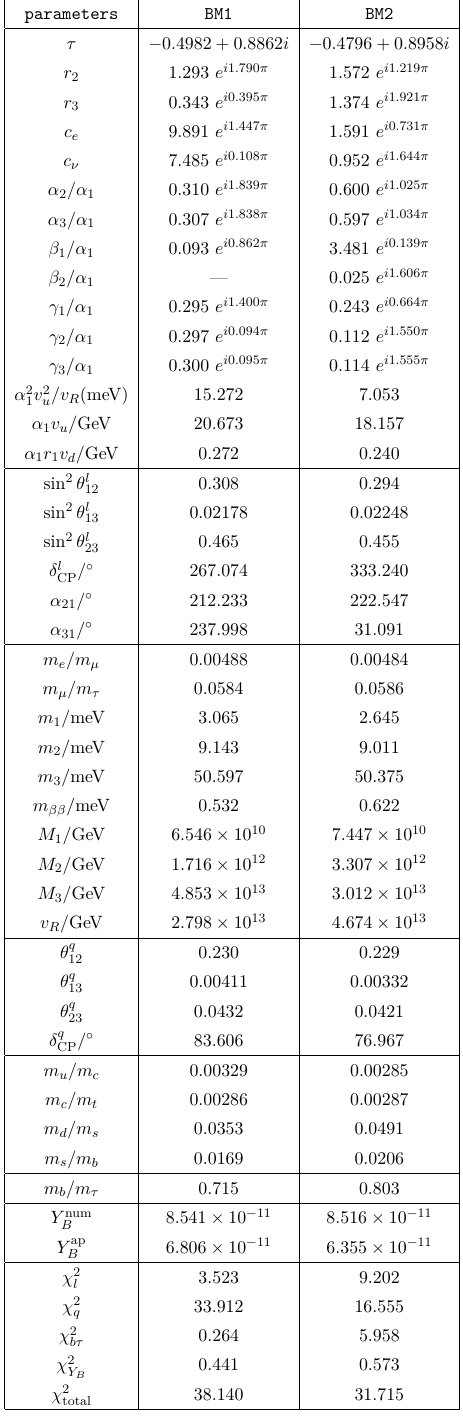
Table 3 . The best fit values of the free parameters and the corresponding predictions for the masses and mixing parameters of leptons and quarks as well as the baryon asymmetry Y B in the two typical models BM1 and BM2 . We assume vanishing initial abundance of the right-handed neutrinos, Y num is the numerical result from density matrix equation, and Y ap approximation in section